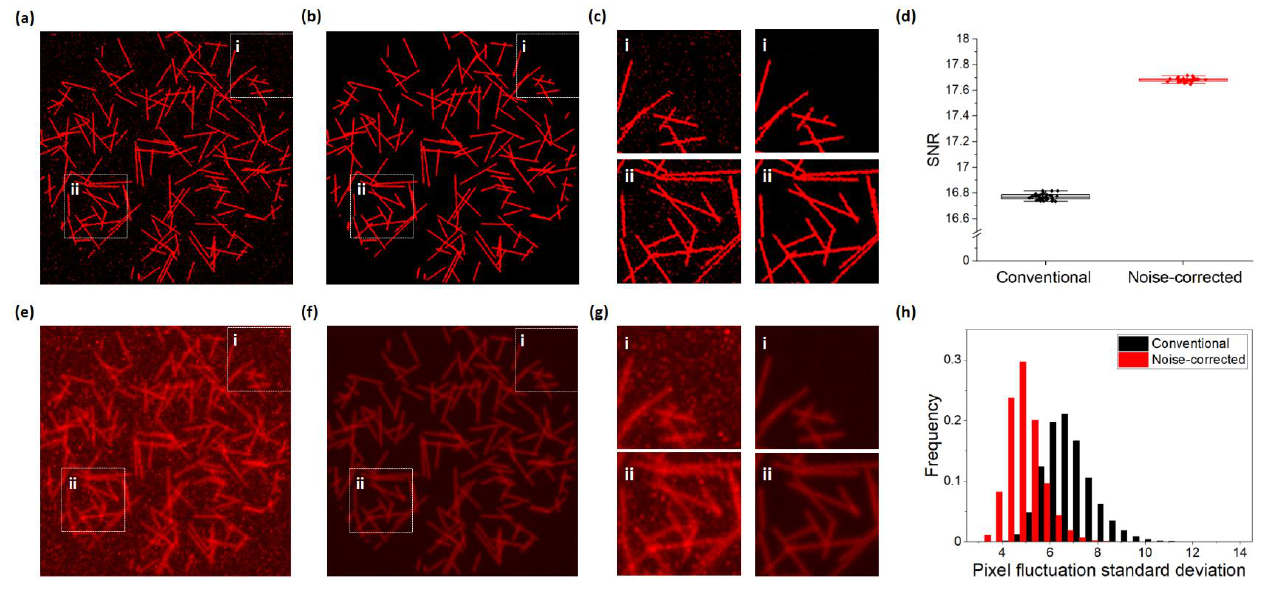
Figure 3. Performance improvement of the sCMOS noise-corrected SIM reconstruction algorithm. ( a ) The conventional algorithm reconstructs the SR image. ( b ) The noise-corrected algorithm reconstructs the SR image. ( c ) Zoomed-in images of selected subregions i and ii in ( a , b ). ( d ) The SNR of the SR image reconstructed by conventional and noise-corrected algorithms. ( e ) Temporal pixel fluctuation map (standard deviation in each pixel over time) over 80 SR images reconstructed by the conventional algorithm. ( f ) Temporal pixel fluctuation map over 80 SR images reconstructed by the noise-corrected algorithm. ( g ) Zoomed-in ROI of selected subregions i and ii in ( e , f ). ( h ) The distribution of pixel fluctuation standard deviation corresponds to conventional and noise-corrected algorithms.